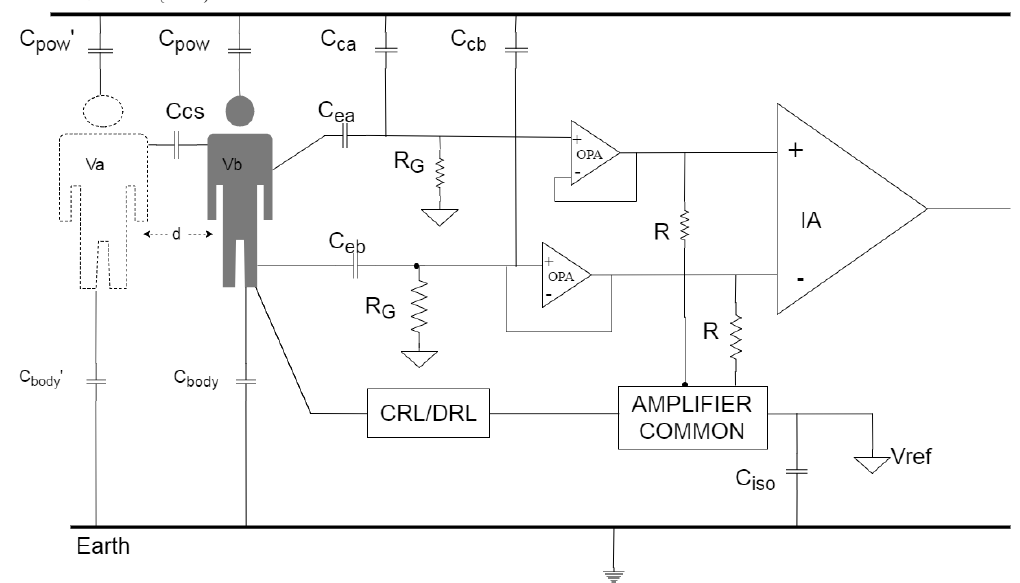
Figure 1. Capacitive coupling between two individuals for an ECG measurement in progress.